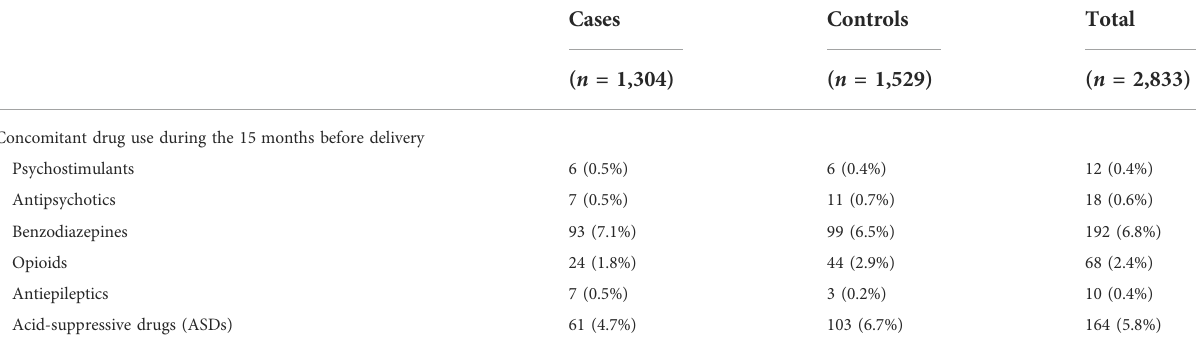
TABLE 2 Crude and adjusted odds ratios for the development of ADHD in offspring after exposure to antidepressants during pregnancy. Crude OR (95%